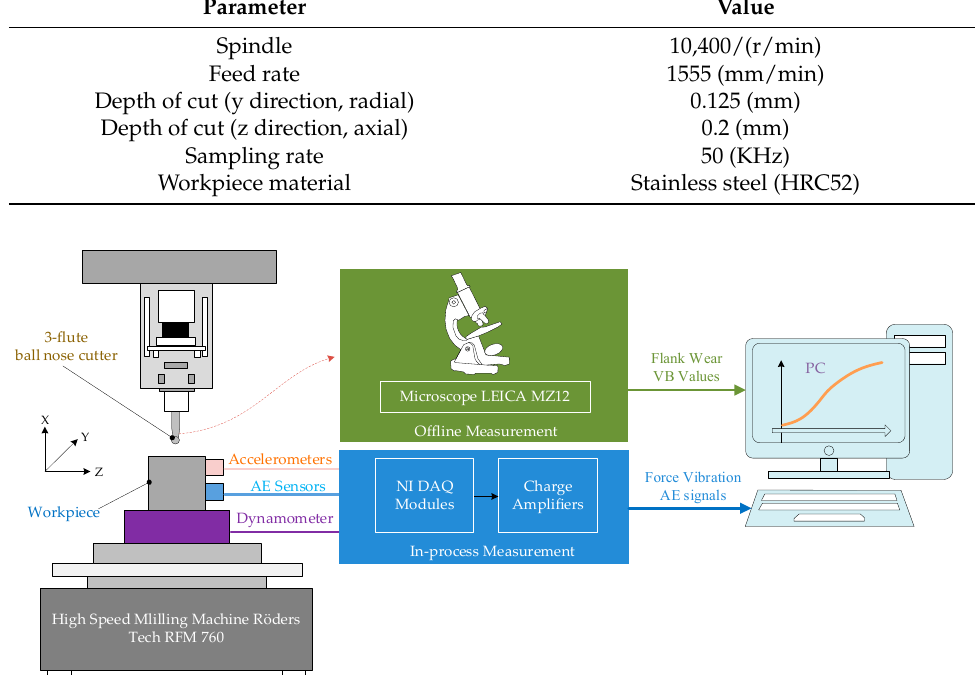
Table 2. Experimental processing parameters.